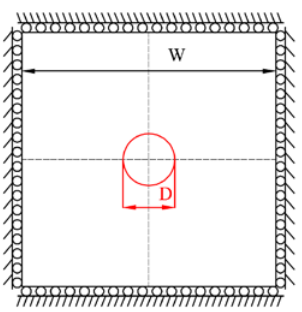
Figure 19. Sketch of model geometry and boundary conditions. Table 5. Parameters for rock mass.